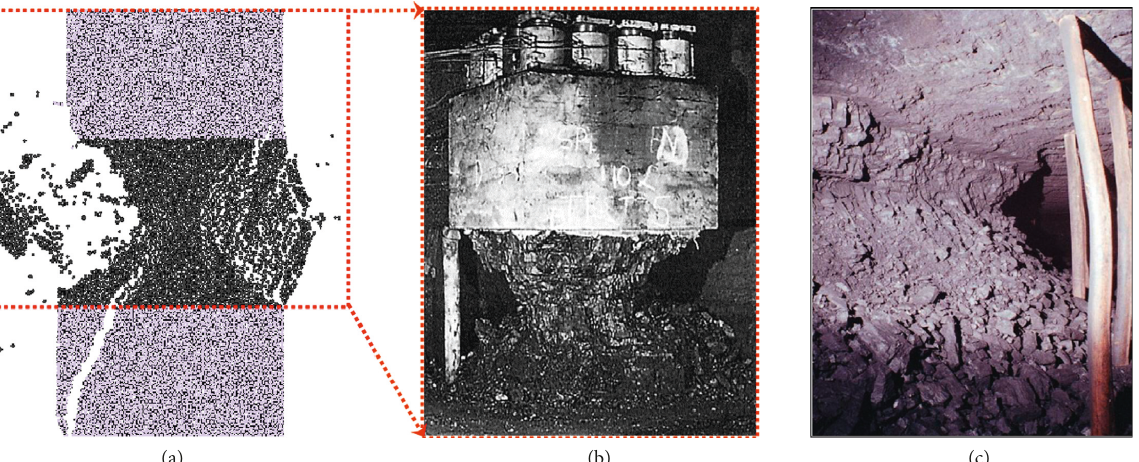
Figure 16: Comparison between the simulation results (left) and the in situ test results (right). (a) Failure mode of an RCR sample; (b) and (c) are the failure modes of the in situ pillars [45,